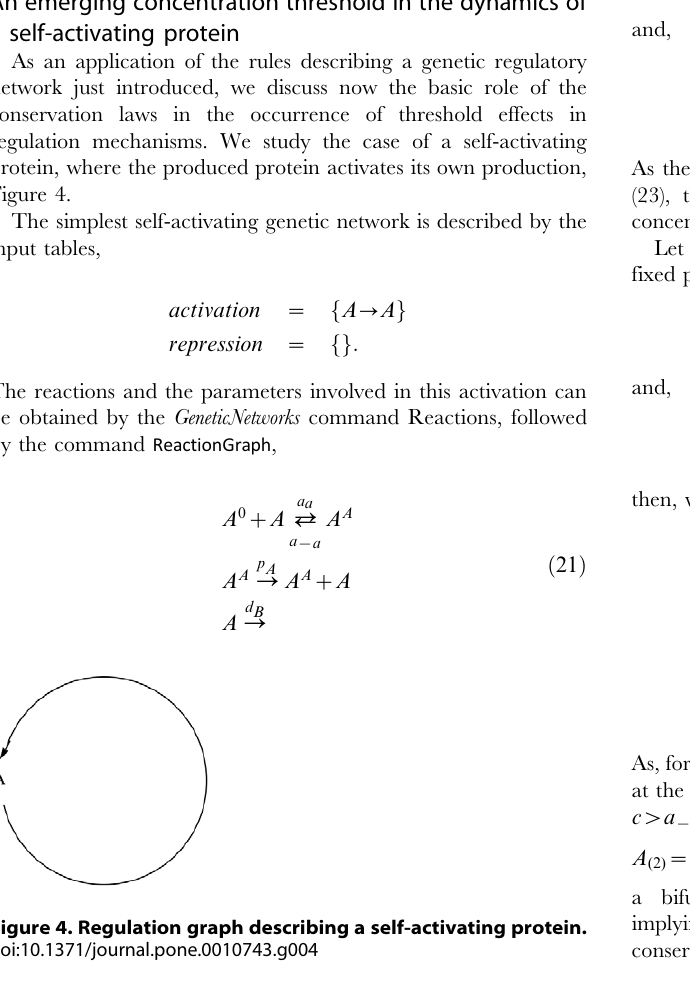
conservation law parameter c .